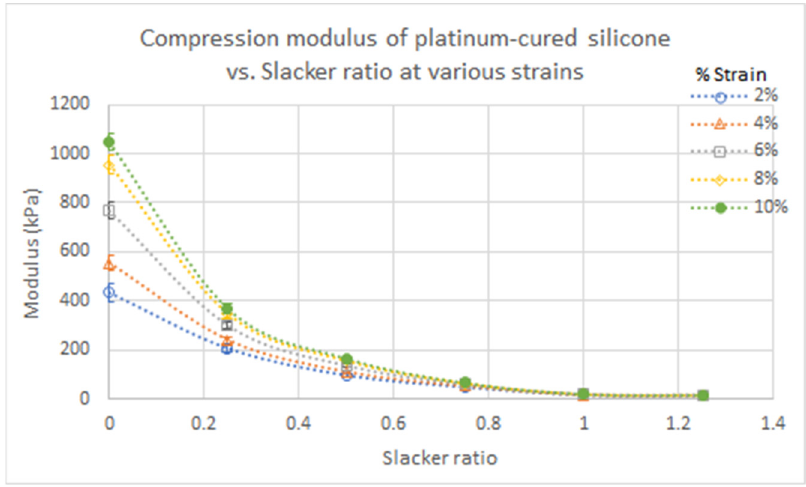
Polymers 2021 , 13 , x FOR PEER REVIEW Figure 2. ( a ) Dielectric constant and ( b ) conductivity of condensation-cured silicone relative to Thi-vex concentration.